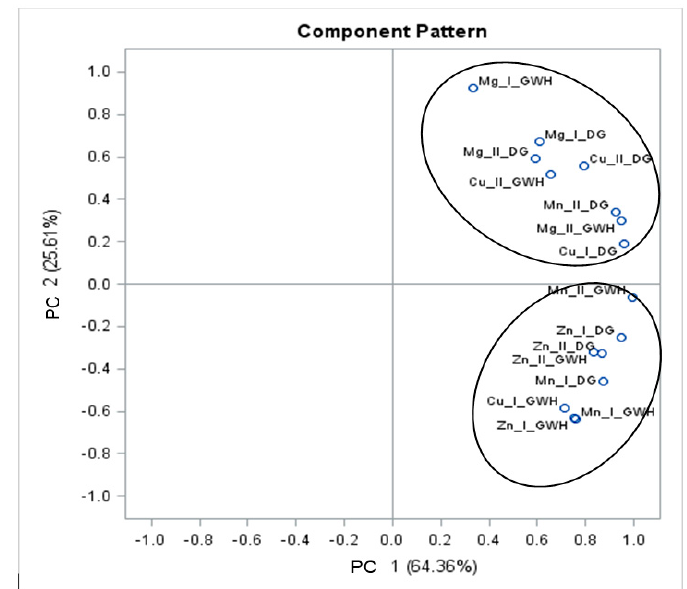
Figure 4. Principal component analysis in assessment of total content of analysed minerals and their amount released by in vitro digestion of buckwheat grains. Explanatory notes: Mg I, Mn I, Zn I, Cu